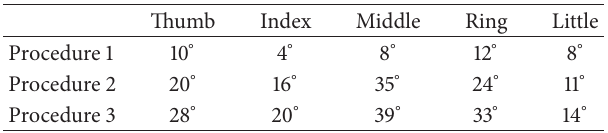
Figure 3: A 1cm proximal excursion of the first point on the flexor tendon proximal to the A1 pulley was provided by the proximal pull of both finger flexors or thumb flexor of one finger at a time. Table 1: The entrance angles of tendons of all digits to A1 pulley according to the procedure.